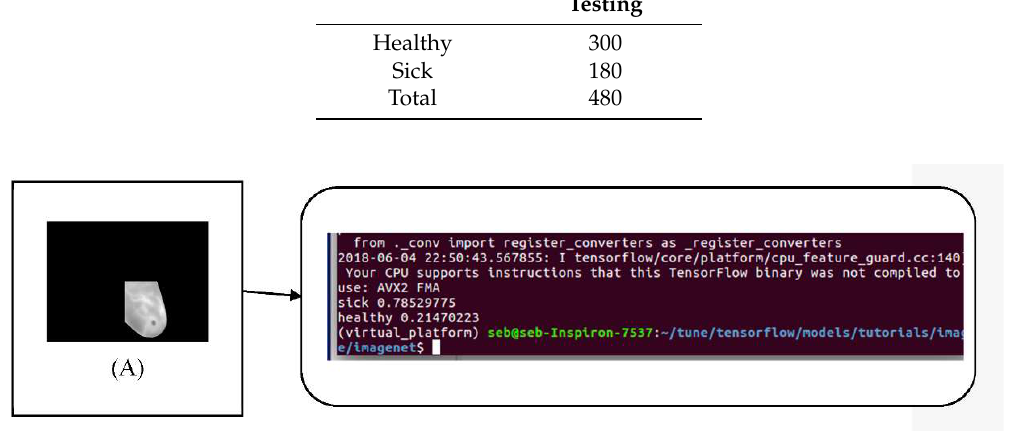
Figure 19. Given image ( B ) as input, our model classifies the image as “healthy” with a confidence of 0.94. 5. Conclusions During the review of the literature, it became apparent that work in the area of breast cancer detection from a computer scientist point of view could be a valuable contribution to the field. With this in mind, we presented the techniques most commonly used to detect breast cancer, and their strengths and weaknesses. One technique in particular appeared to have a promising future, because of its non-immersive property and the significant amount of data that needs to be processed with more efficient techniques. Infrared imaging coupled with an agent previously administered to a patient can lead to a very accurate tumor detector. In a future study, we will use a thermal sensitivity camera of 0.5, and propose a model of the breast which will be able to help us to realize an even more precise diagnosis. Funding: The work and the contribution were supported by the SPEV project No. 2018/2102 “Smart Solutions in Ubiquitous Computing Environments”, 2018, University of Hradec Kralove, Faculty of Informatics and Management, Czech Republic. Conflicts of Interest: The authors declare no conflicts of interest. References 1. National Breast Cancer Foundation. Breast Cancer Facts ; National Breast Cancer Foundation: Sydney, Australia, 2016. 2.